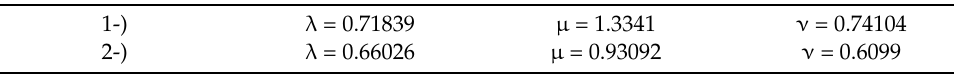
Table 4. Physically meaningful solutions (first method).